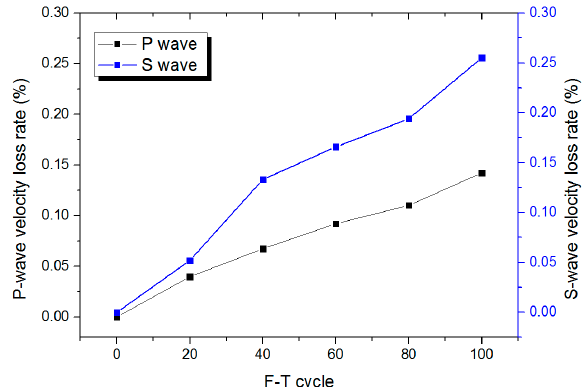
Figure 6. Relationships between the P and S-wave velocity loss rates and the freeze–thaw cycles.